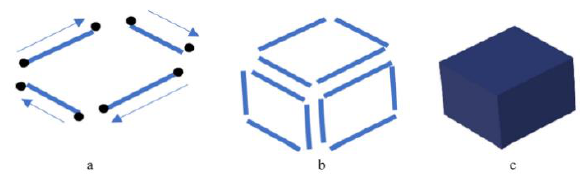
Figure 3 . 3D volumetric parcel structure composed of (a) 3D nodes and lines, (b) 3D face and (c) 3D parcel (Jaljolie et al.,